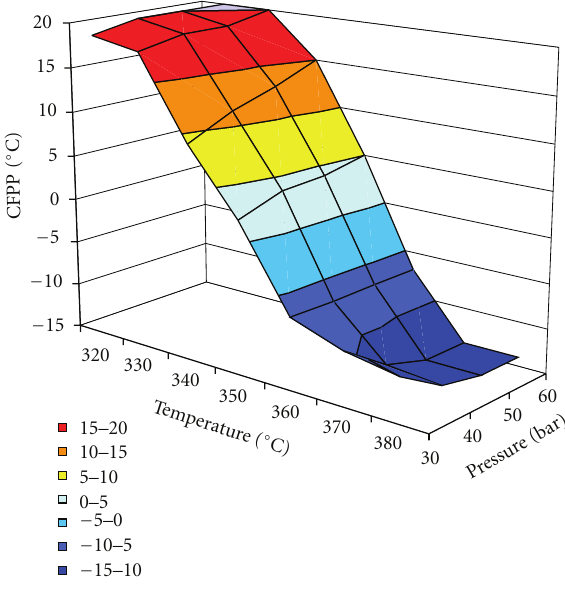
Figure 13: CFFP values of the products as a function of tempera- ture, pressure and